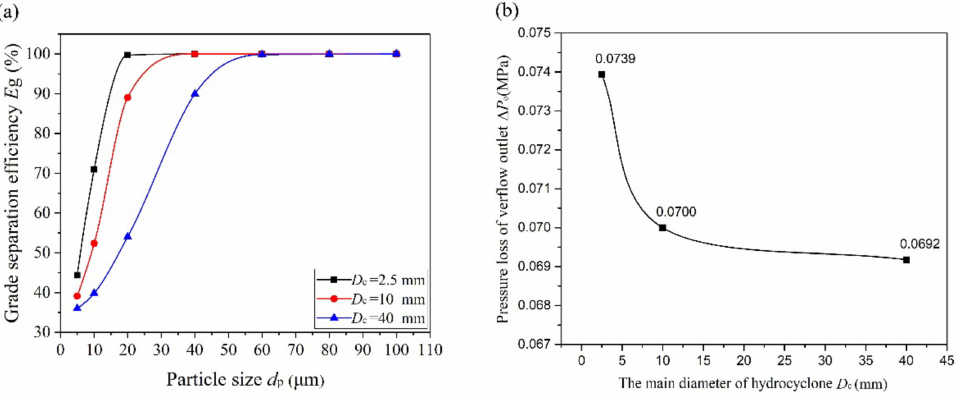
Figure 11. Comparison of grade separation efficiency and pressure loss of hydrocyclone with different main diameters for silica-water separation. ( a ) Grade separation efficiency; ( b ) Pressure